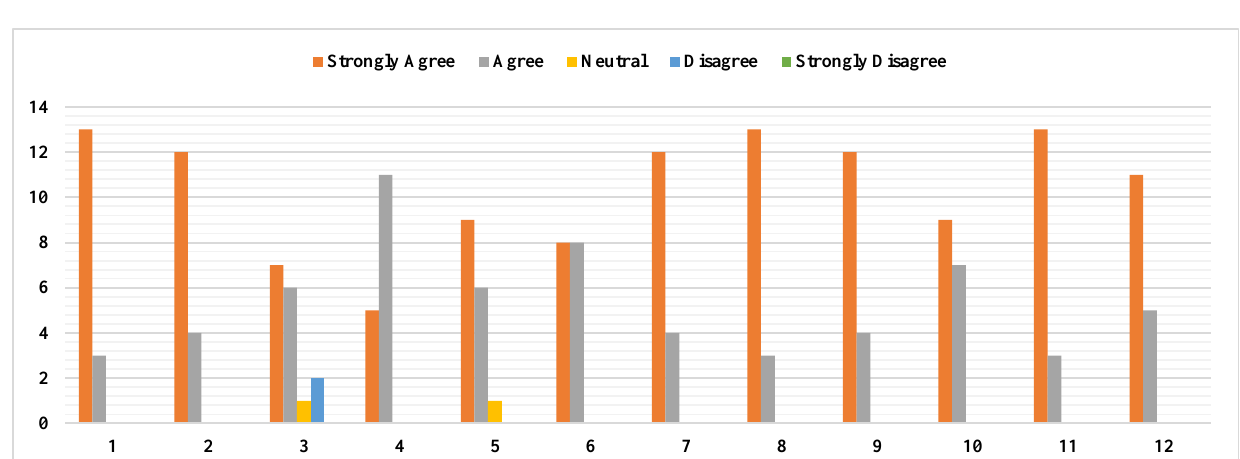
Figure 11. Distribution of answers to the multiple-choice questions of the first